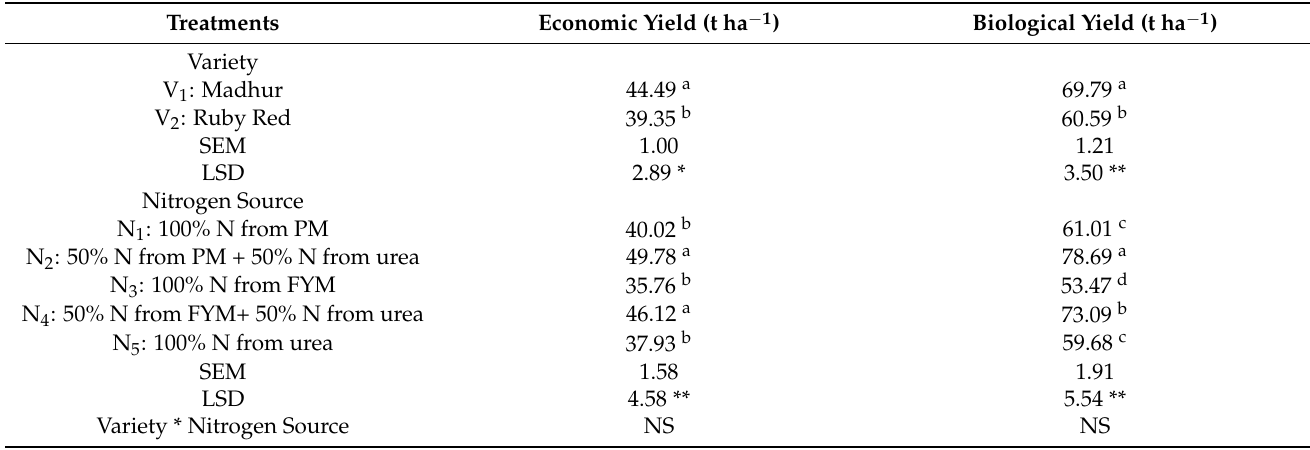
Table 8. Effect of variety and nitrogen source on economic (root) and biological yield of beetroot at AFU, Rampur, Chitwan in